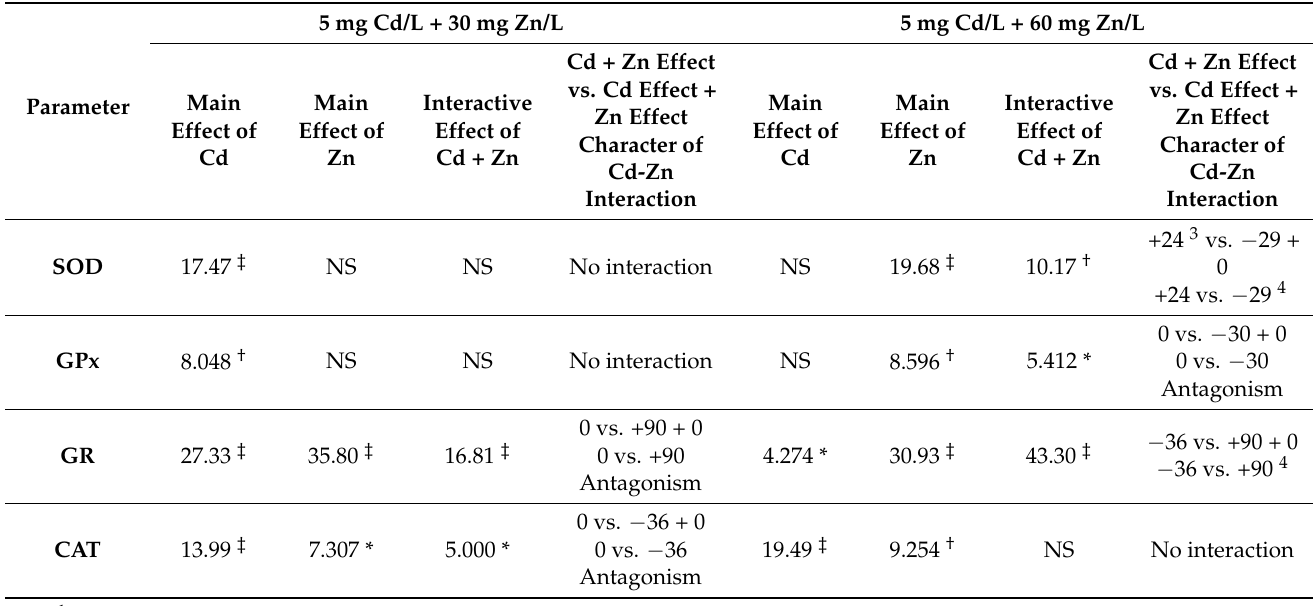
Table 2. Interactive and main effects of cadmium (Cd) and zinc (Zn) on the activities of superoxide dismutase (SOD),